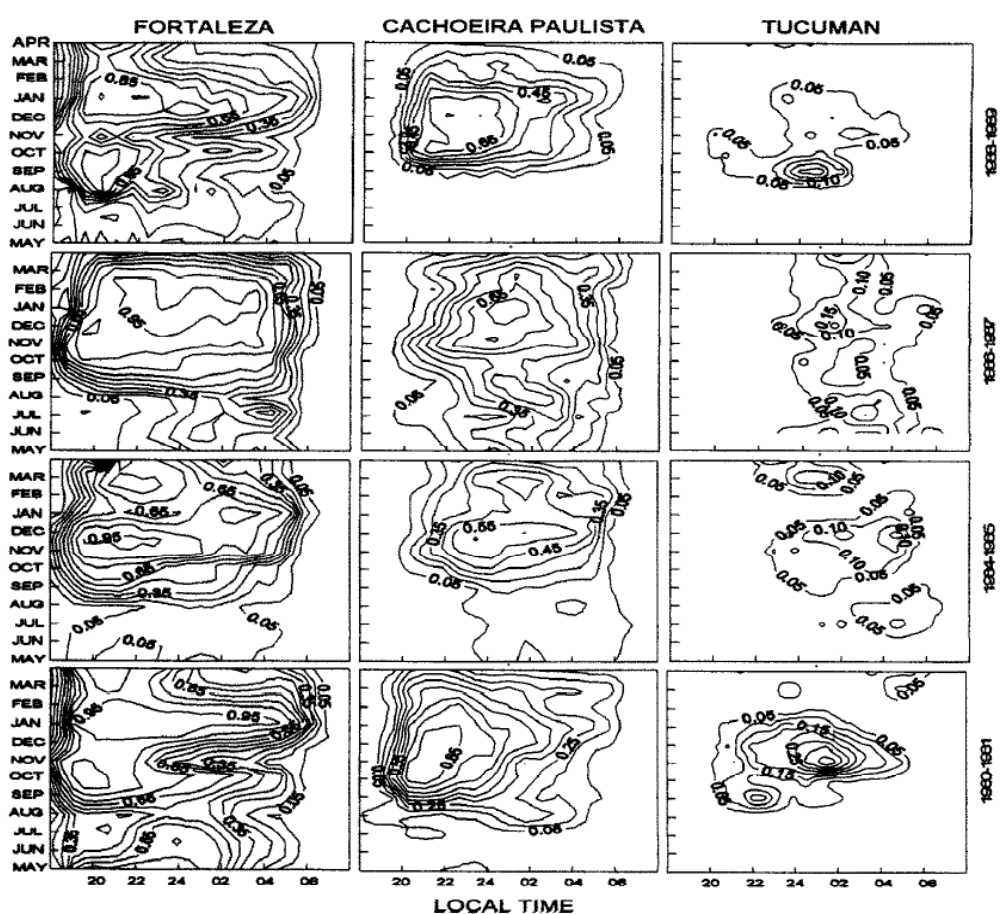
Fig. 4. Frequency of occurrence of Spread F for the Eastern South American sector (after Abdu et al., 1998). Figure 4. Frequency of occurrence of Spread F for the eastern South American sector (after Abdu et al., 1998). final product both ways, on transmission and reception. They also affect the accuracy of high precision location using GPS